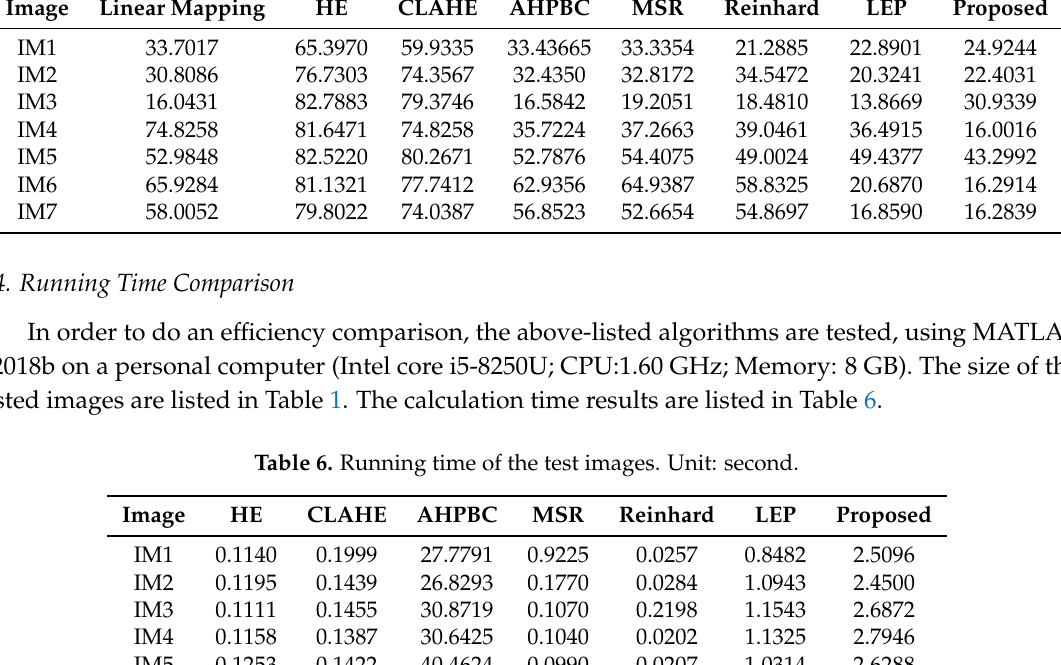
Table 5. The Perception-based Image Quality Evaluator (PIQE) values of the images. Image